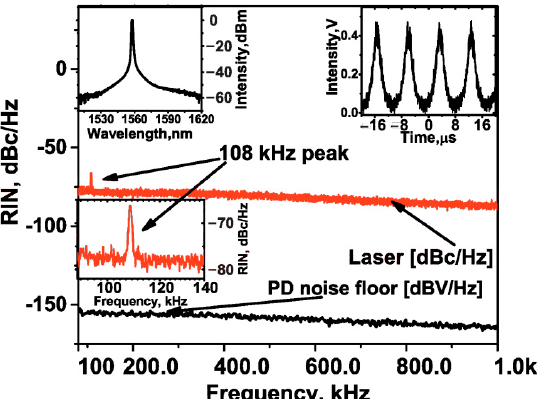
Figure 6. RIN of the Q-switching operation mode and photodetector (PD) + ESA noise floor. Inset: optical spectrum and output pulse trace.